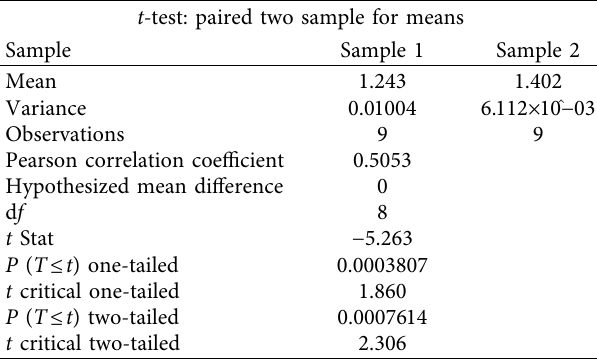
Table 10: t -test for the indirect tensile strengths of two types of core